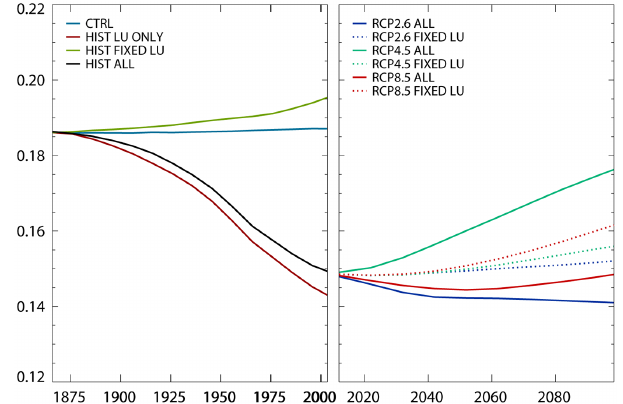
Figure 11. Fractional cover of broadleaf tree in northern South America simulated by HadGEM2-ES under historical forcings (left panel) and 3 of the 4 RCPs (right panel) with different combinations of climate and land use (LU) drivers. In the left panel, historical sim- ulations were driven by; historical land use only, with no change in greenhouse gas concentrations (HIST LU ONLY: red line); green- house gas changes but with land use fixed at the initial state in 1860 (HIST FIXED LU: green line); and a combination of the previous two (HIST ALL: yellow line). The control simulation with no ex- ternal forcing is also shown (CTRL: blue line). In the right panel, dark lines (ALL) show simulations driven by greenhouse gas and land use changes for RCP2.6, RCP4.6 and RCP8.5, and faded lines (FIXED LU) show simulations driven with greenhouse gas changes but with land use fixed at the 2005 state.